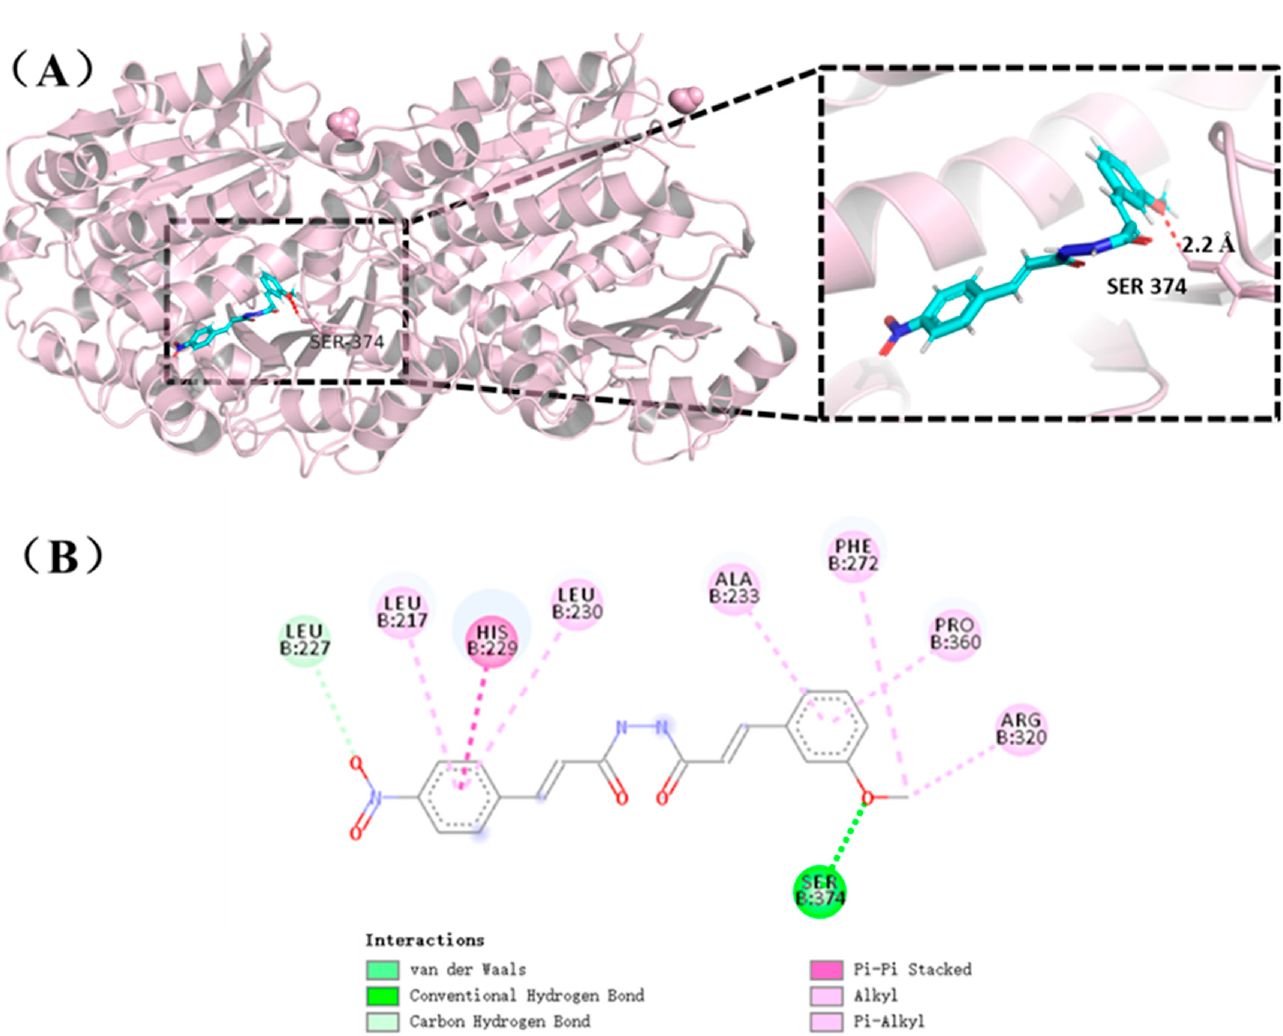
Figure 7. Predicted binding modes of compound I 23 with tubulin. Binding of I 23 into the active site of tubulin was performed by PyMol software ( A ) and the 2D diagram of binding modes was shown through Discovery Studio 4.5 software ( B ).